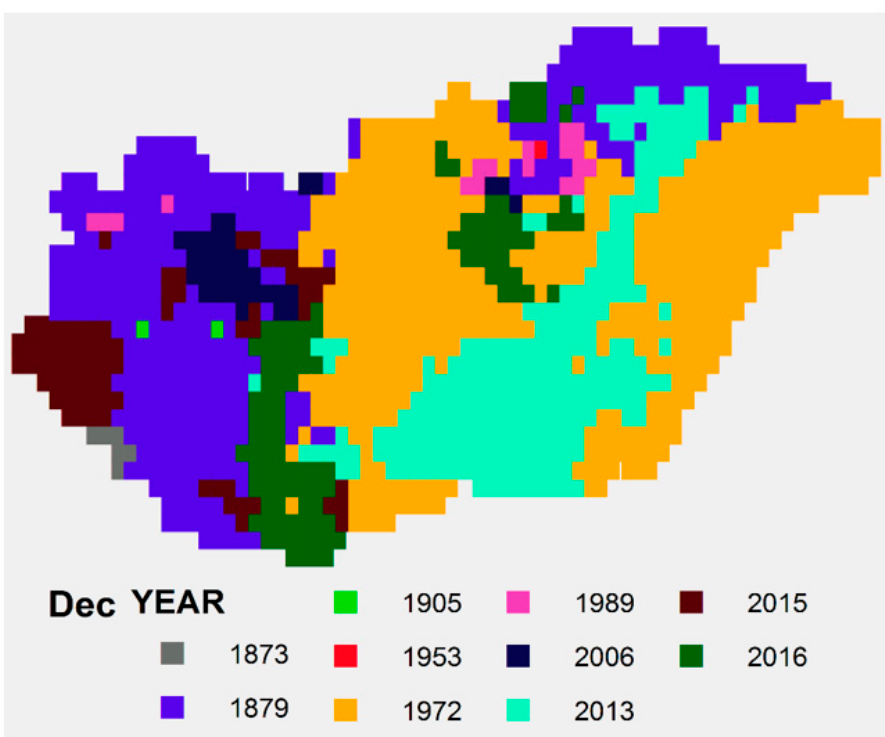
Figure A21. December: Year of maximum SPTI values, 1871–2020.